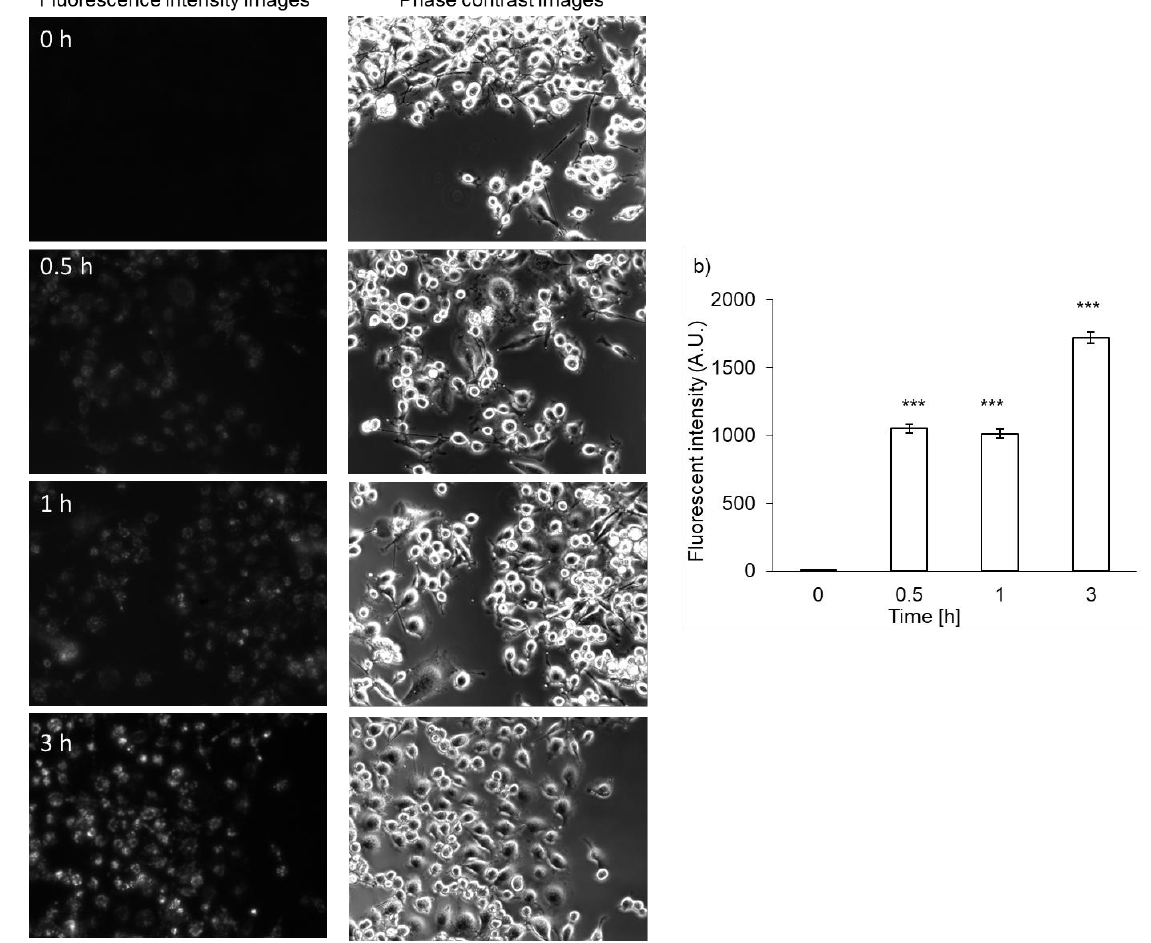
Figure 6. Intracellular PLP accumulation in NOZ cells. Microscopy images ( a ) and intracellular fluorescence intensity ( b ). Data are expressed as means ± SD ( n = 5). *** p < 0.001.